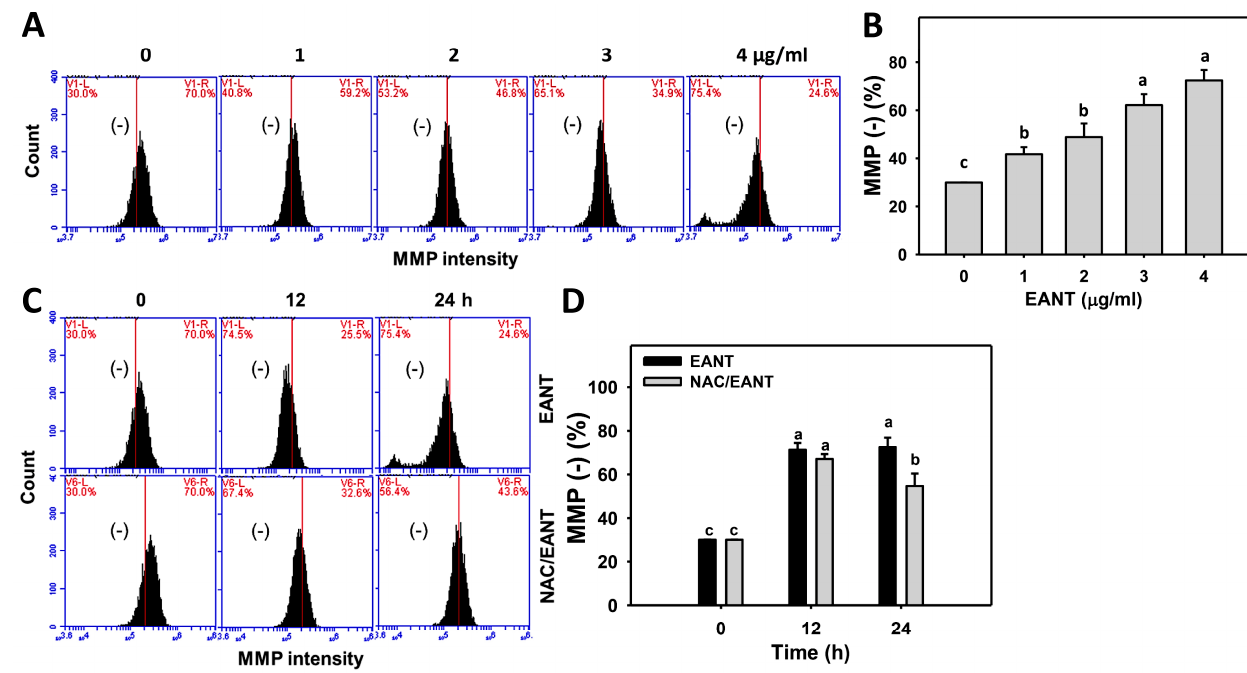
Figure 7. MMP content of EANT-treated leukemia cells. ( A and B ) Histogram and statistical analysis for MMP content. ( − ) on the left side of each panel is regarded as the population of MMP ( − ) (%). HL-60 cells were treated with EANT (1 h, 0 to 4 μ g/mL). The 0 μ g/mL solution meant no EANT but contained 0.1% DMSO. ( C and D ) Histogram and statistical analysis for MMP content of HL-60 cells following NAC/EANT treatment. NAC/EANT indicates that cells are either pretreated with NAC (5 mM, 1 h) or post-treated with EANT (0 and 4 μ g/mL for 0, 12, and 24 h). Data, mean ± SD ( n = 3). Data showing different letters on the top reveal a significant difference ( p < 0.05–0.0001 for multiple comparisons).